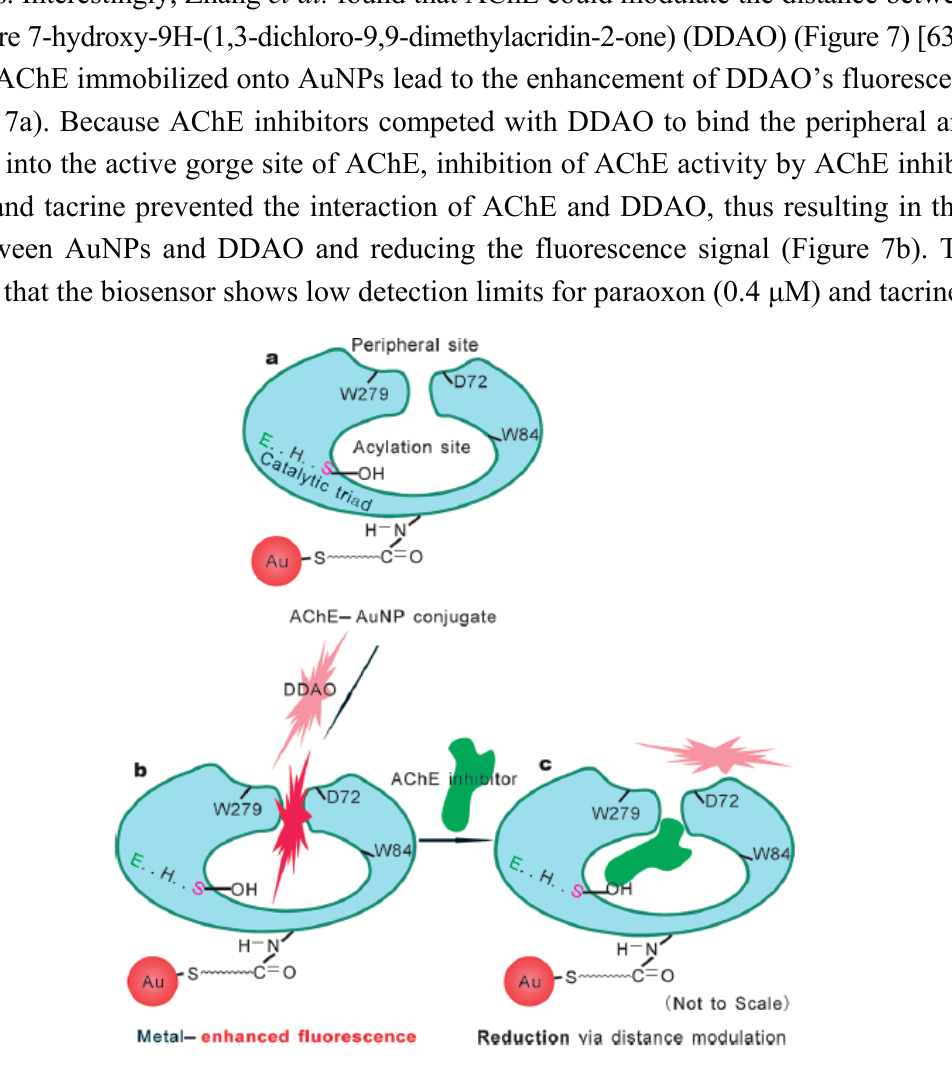
Figure 7. Schematic illustration of the strategy for the “on-off” type of fluorescent nanobiosensors for AChE inhibitors. ( a ) Fabrication of AChE-AuNP conjugate via EDC/NHS coupling chemistry; ( b ) Metal enhanced fluorescence of DDAO bound with the active sites of AChE via distance regulation between the fluorophore and AuNP; ( c ) The fluorescence reduction via distance modulation due to AChE inhibitor binding. Reprinted with permission from [63]. Copyright 2012 American Chemical